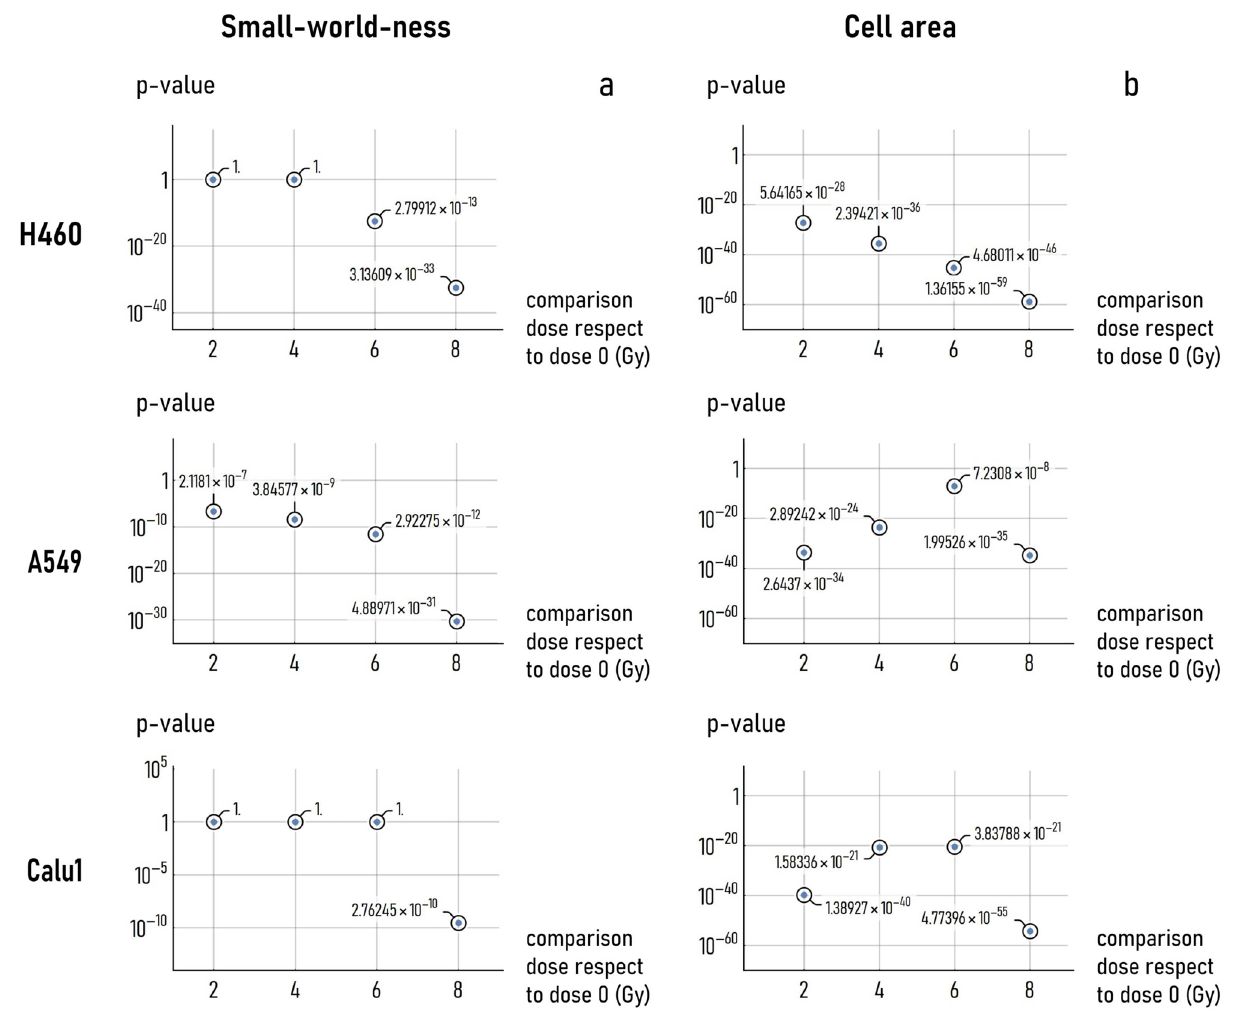
Figure 6. Statistical analysis of cell-graphs topology and morphology. Diagrams in ( a ) show the p -value associated to a Student’s T-test comparison statistics between the SW coefficient derived for non-exposed cells (0 Gy) and cells exposed to 2, 4, 6 and 8 Gy dose. Diagrams in ( b ) show the p -value associated to a Student’s t -test comparison statistics between the area determined for non-treated cells (0 Gy) and cells exposed to 2, 4, 6 and 8 Gy dose. The smaller the p -value, the larger the statistical significance of the difference between the topology/morphological parameters measured for cells subjected or not to external